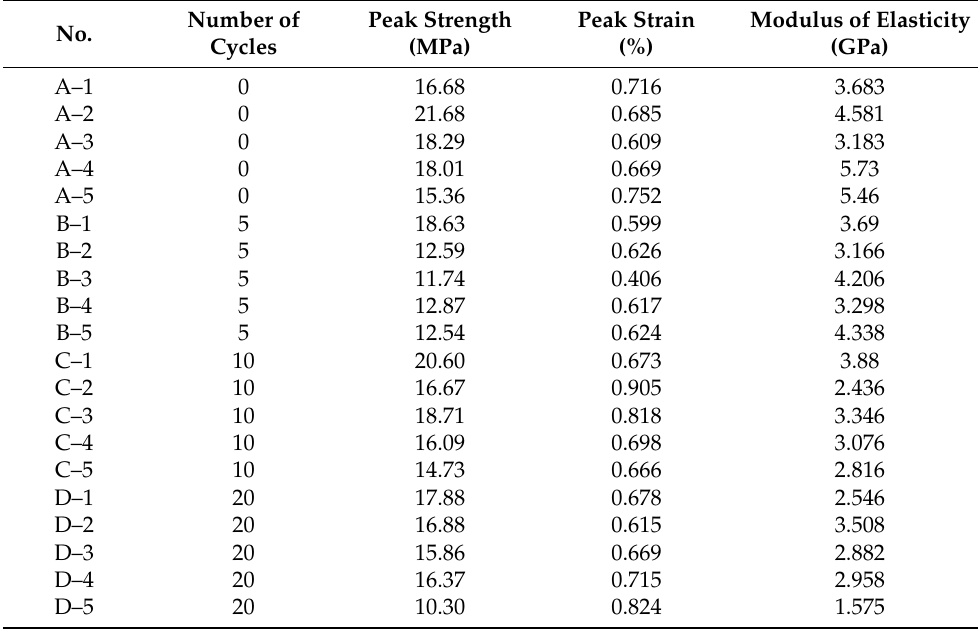
Table 1. Mechanical properties of crack-grouting rock specimen under uniaxial compression under wetting–drying